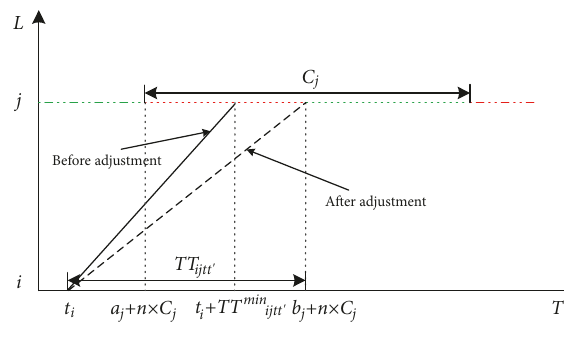
Figure 7: The adjustment of actual travel